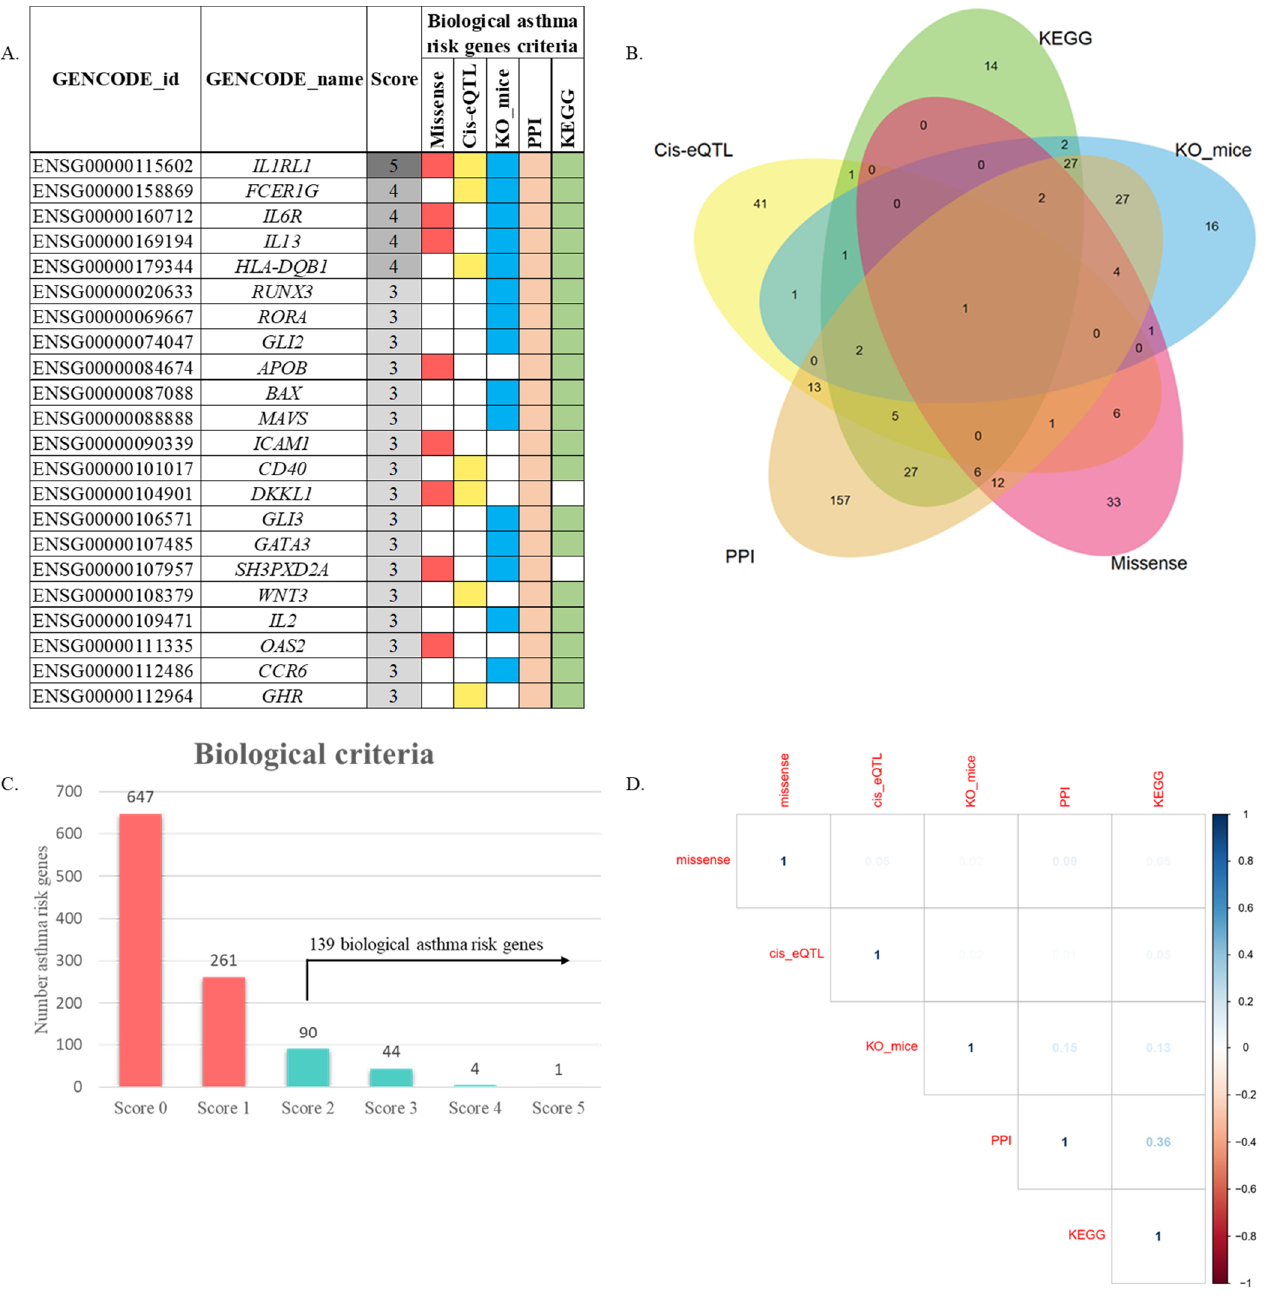
Figure 2. Prioritization of biological candidate gene from asthma risk loci. ( A ) Summary scores derived from 5 criteria are shown. The boxes are filled with different colors to distinguish each functional annotation. Filled boxes indicate fulfilled criteria. Gene with a score ≥ 2 was defined as “biological asthma risk genes.” For complete information, see Table S3. ( B ) Venn diagram shows the prioritization criteria of the biological candidate gene from asthma risk loci. ( C ) Histogram distribution of gene scores. The figure shows 139 genes with total scores ≥ 2. ( D ) Correlogram indicates the pairwise Phi correlation coefficient between the five criteria. The blue color denotes a positive correlation, while the red color denotes a negative correlation.